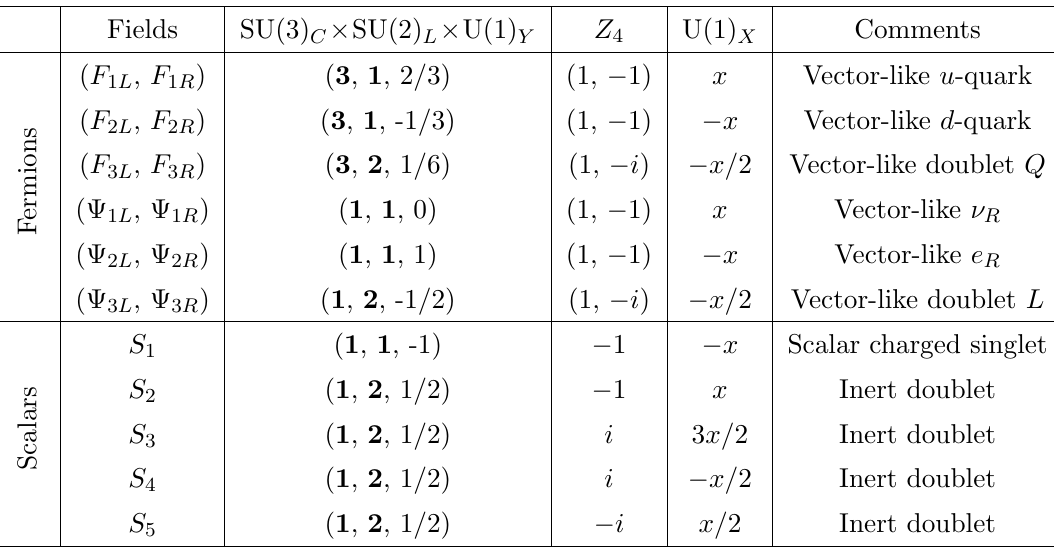
Table 2 . Charge assignments for the fermions and scalars contributing to the diagrams (cid:12)gures 1{4, considering that all the scalars are color blind. In the brackets of the Z 4 -column we indicate the corresponding charges of the left-handed and right-handed vector-like fermions, respectively. The U(1) X global symmetry and the (cid:12)eld charges are discussed in section